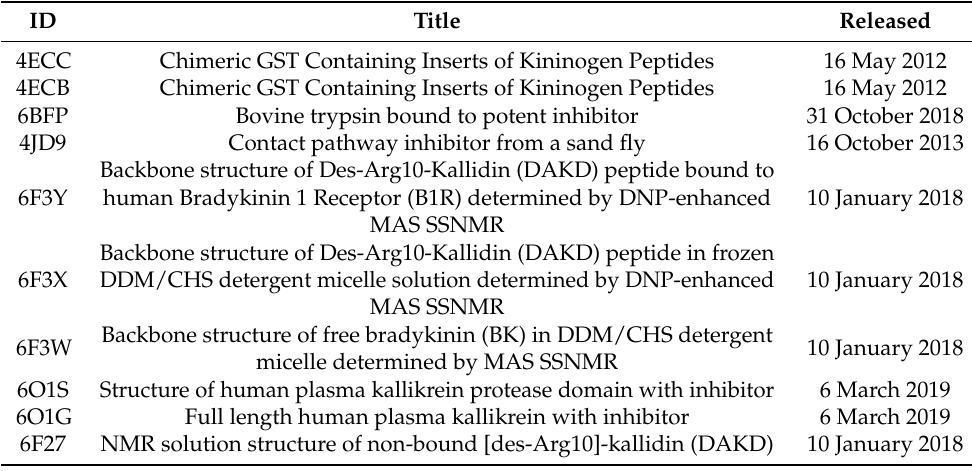
Table 2. The best ten of 39 hits for searching “kininogen” keyword against RCSB PDB: